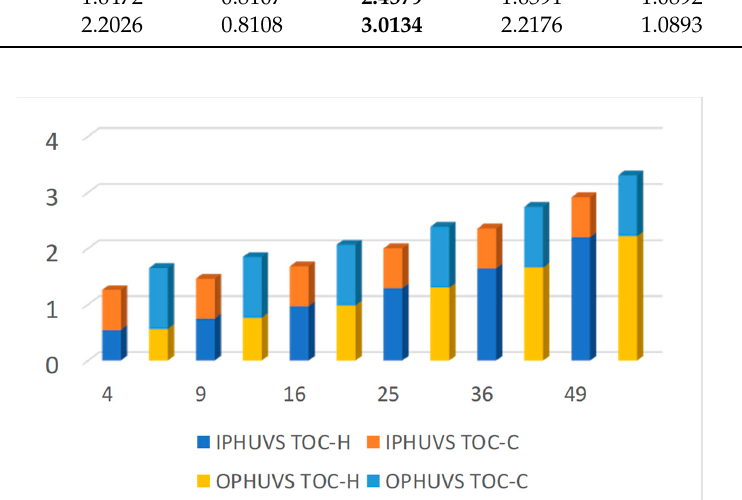
Figure 12. TOC of original PHUVS and improved PHUVS with different numbers of feature points.